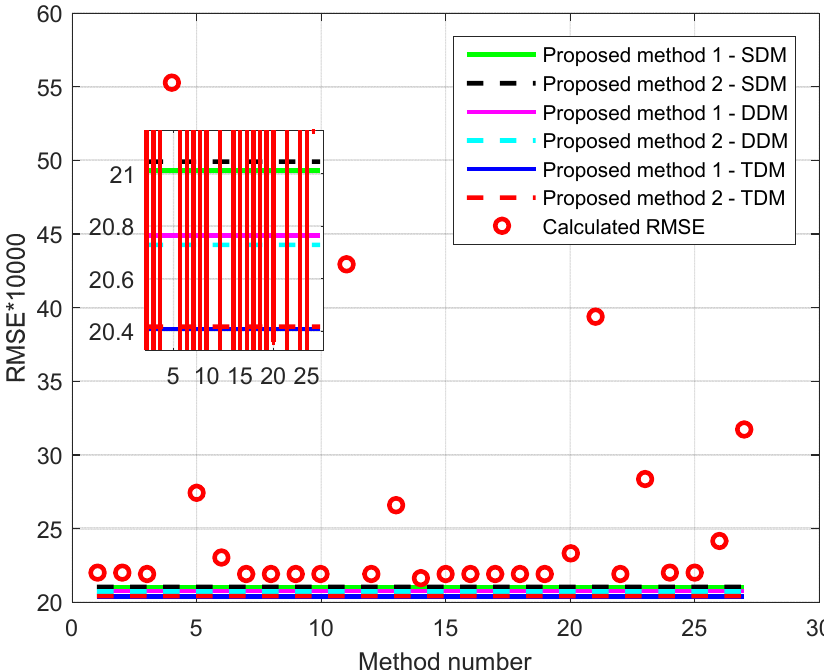
Figure 4. RMSE comparison for methods used to estimate the Photowatt-PWP201 module parameters.